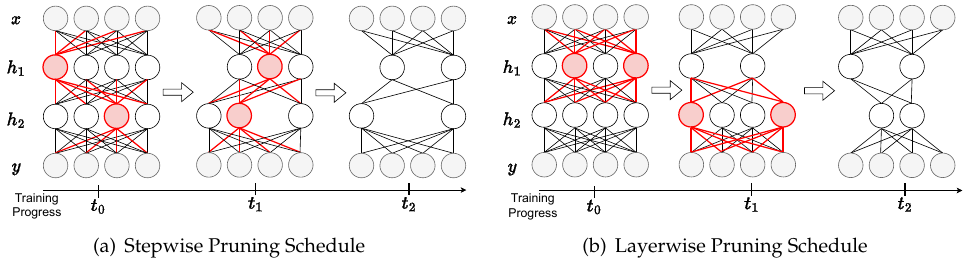
Figure 5. We depict the differences between the standard stepwise pruning schedule ( a ) and our layerwise pruning schedule ( b ). While stepwise pruning algorithms iteratively increase sparsity globally in the network with each step, our layerwise pruning algorithm iteratively increases sparsity layer-by-layer with each step. Throughout the training progress (horizontal flow), gray nodes denote visible neurons that are not pruned, red nodes denote hidden neurons that have been identified to be pruned in a given step, and white nodes denote hidden neurons that remain active.